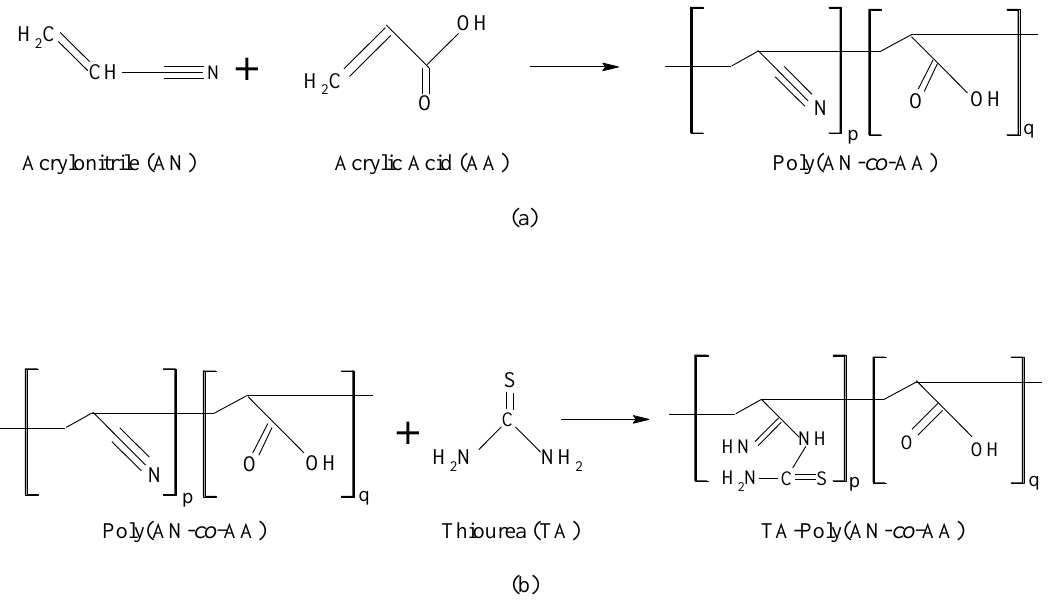
Figure 1. Synthesis of poly(acrylonitrile- co -acrylic acid) (poly(AN- co -AA) ( a ) and its modification with thiourea ( b ) [13].